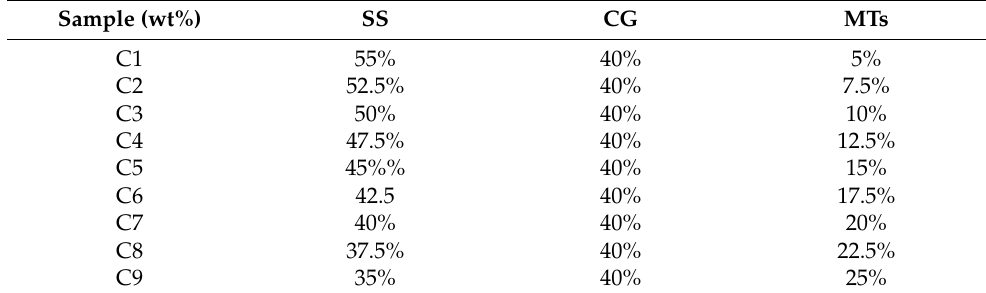
Table 3. The mixing ratios of SS, MTs, and